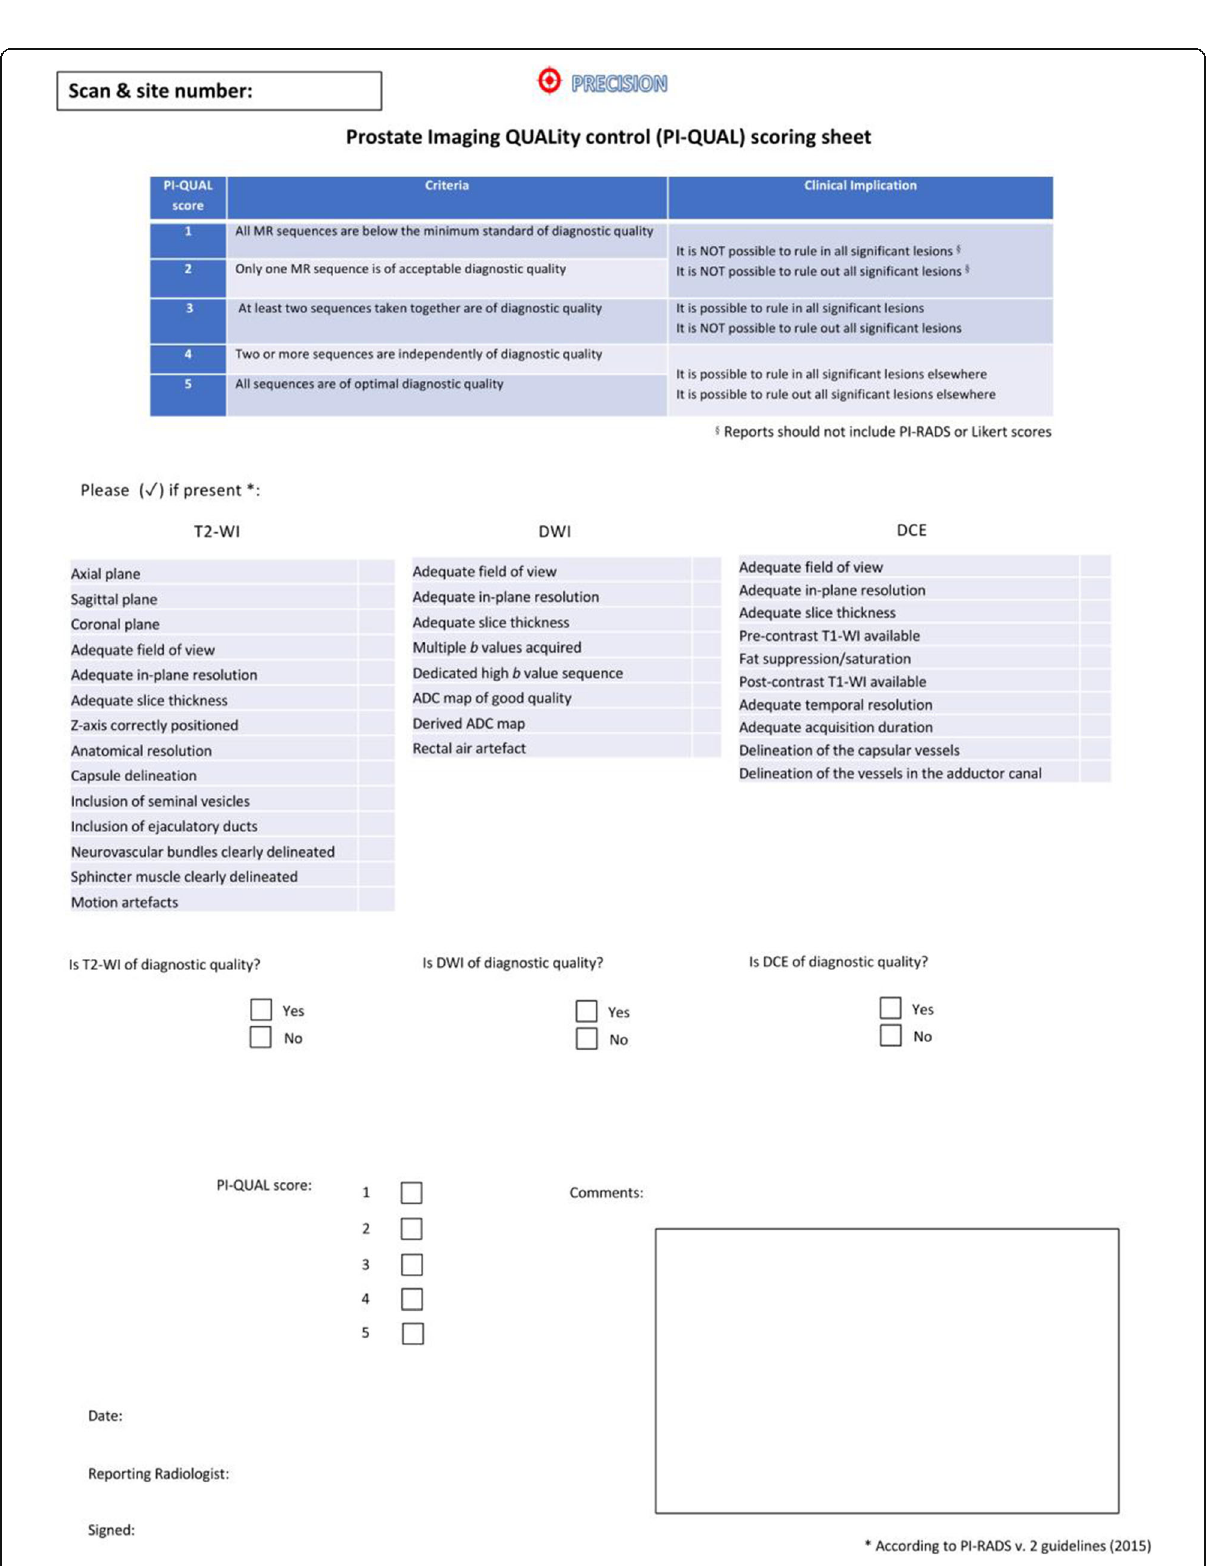
Fig. 1 Scoring sheet for assessing the quality of multiparametric magnetic resonance imaging using the PI-QUAL score. ADC, Apparent diffusion coefficient; DCE, Dynamic contrast-enhanced; DWI, Diffusion-weighted imaging; T2-WI, T2-weighted imaging. Reprinted with permission from